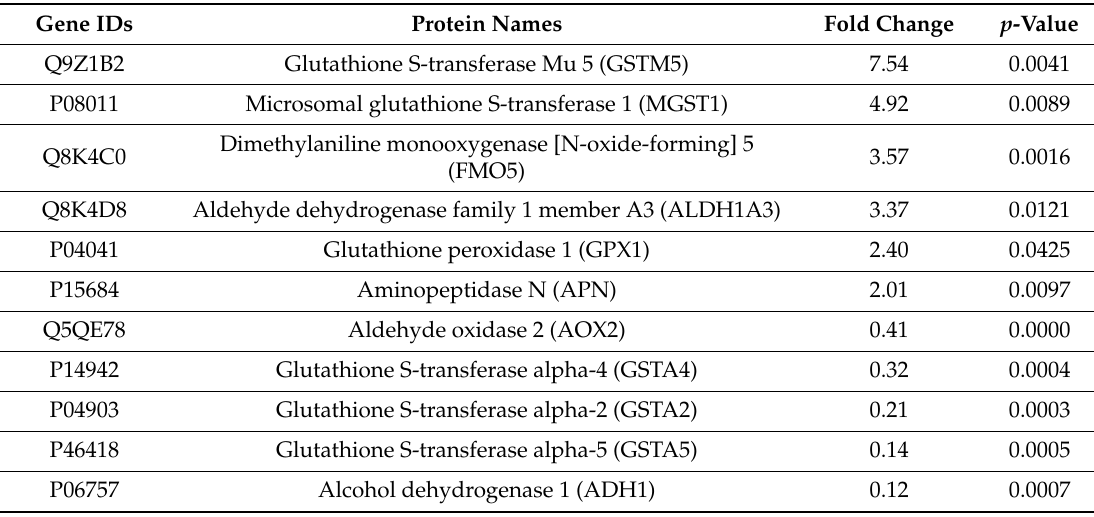
Table 4. DEPs involved in drugs and xenobiotics